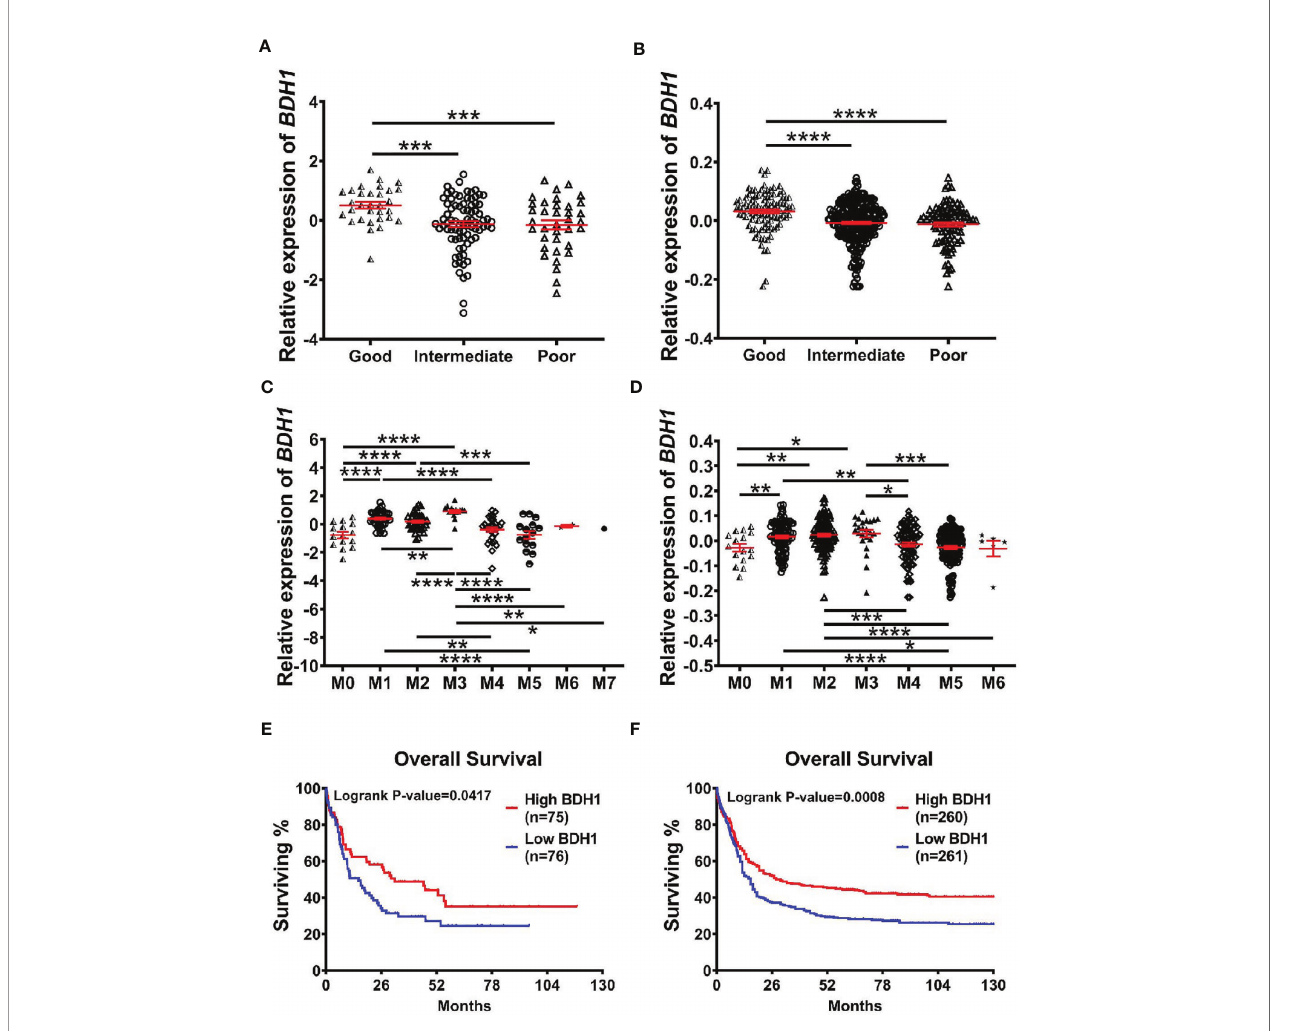
FIGURE 2 | The lower expression of BDH1 predicts the worse prognosis for AML patients. (A, B) Shown are comparisons of BDH1 gene expression levels among AML patients of different cytogenetic-risk classi fi cations in TCGA-LAML database (A) and GSE6891 database (B) , and comparison of BDH1 gene expression among AML patients of different FAB subtypes in TCGA-LAML database (C) and GSE6891 database (D) . The expression values were log2-transformed and mean centered. The P values were detected by t -test. (E, F) Kaplan-Meier survival curves of BDH1 in TCGA-LAML (left) (E) and GSE6891 (right) (F) database. * p < 0.05, ** p < 0.01, *** p < 0.001, **** p <